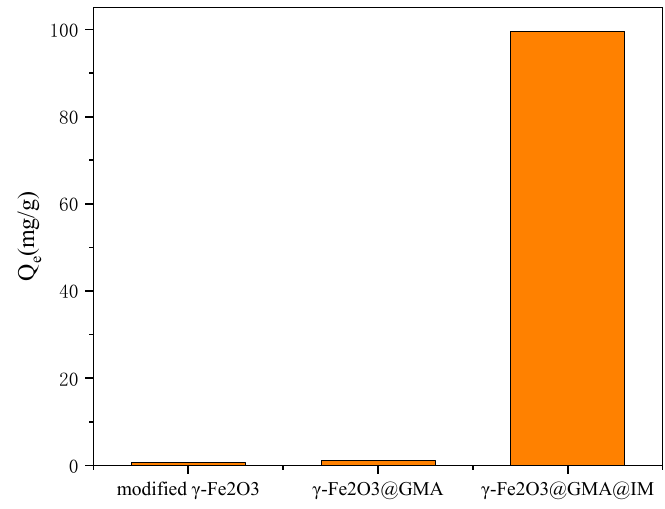
Figure 7. The adsorption capacity of different materials for FCF.